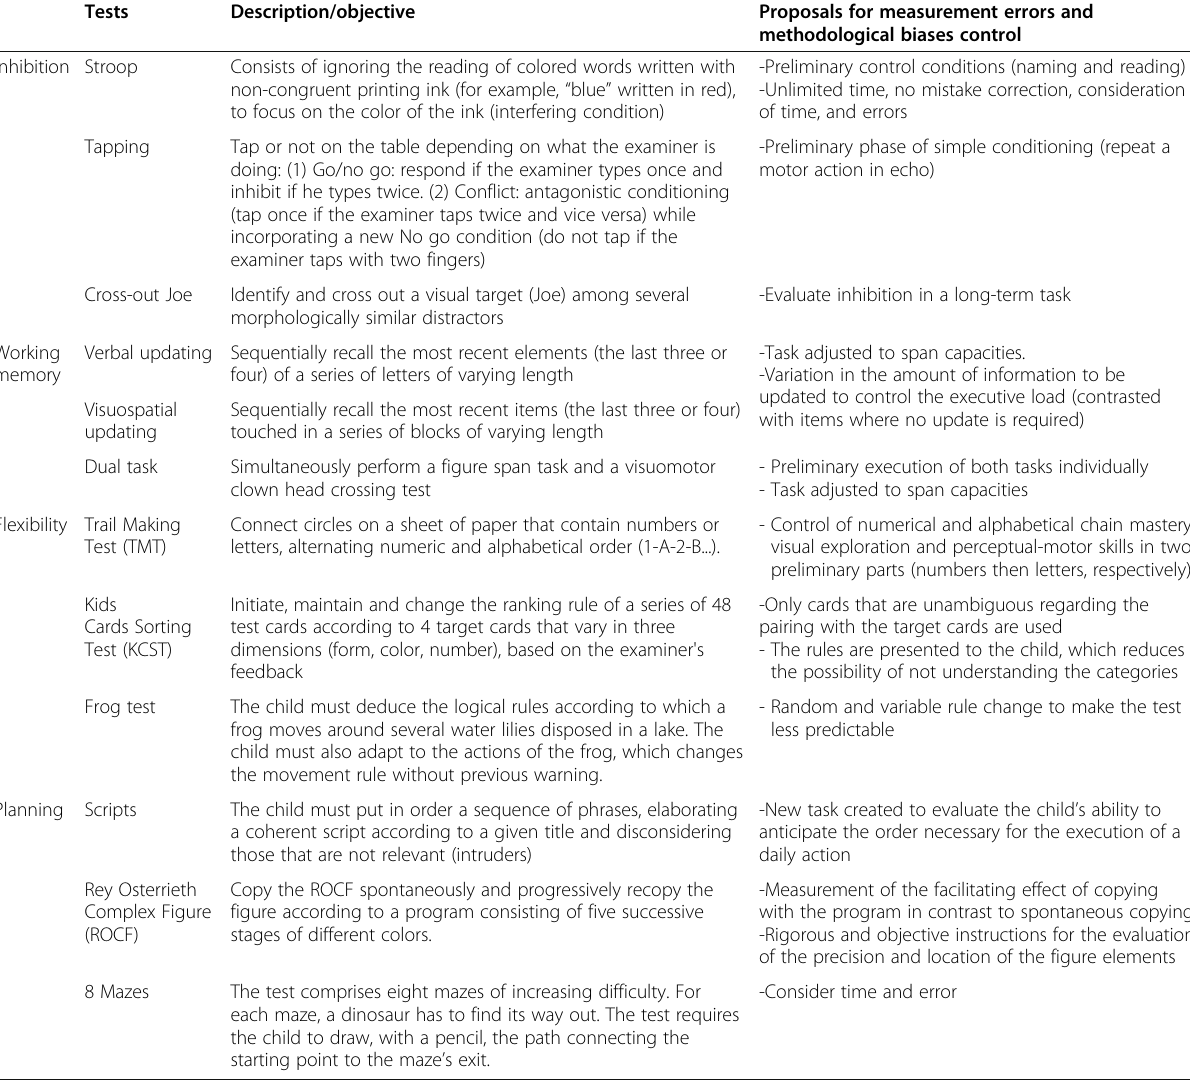
Table 2 Description of CEF-B tests and scientific rationale for controlling measurement errors and methodological bias Tests